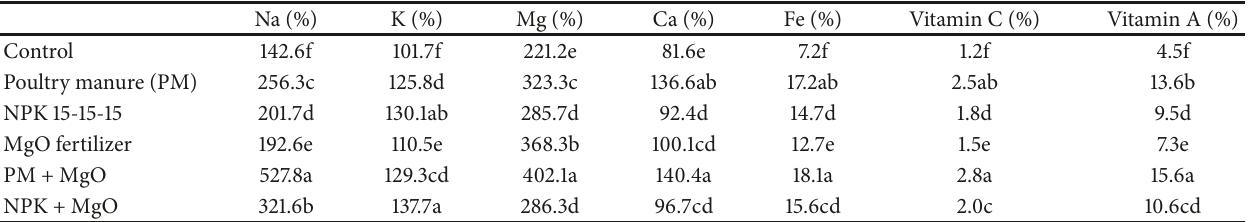
Table 5: Effect of Mg fertilizer, PM, NPK fertilizer, and their combinations on mineral and vitamin contents of turmeric rhizome (means of 2017 & 2018 pooled).